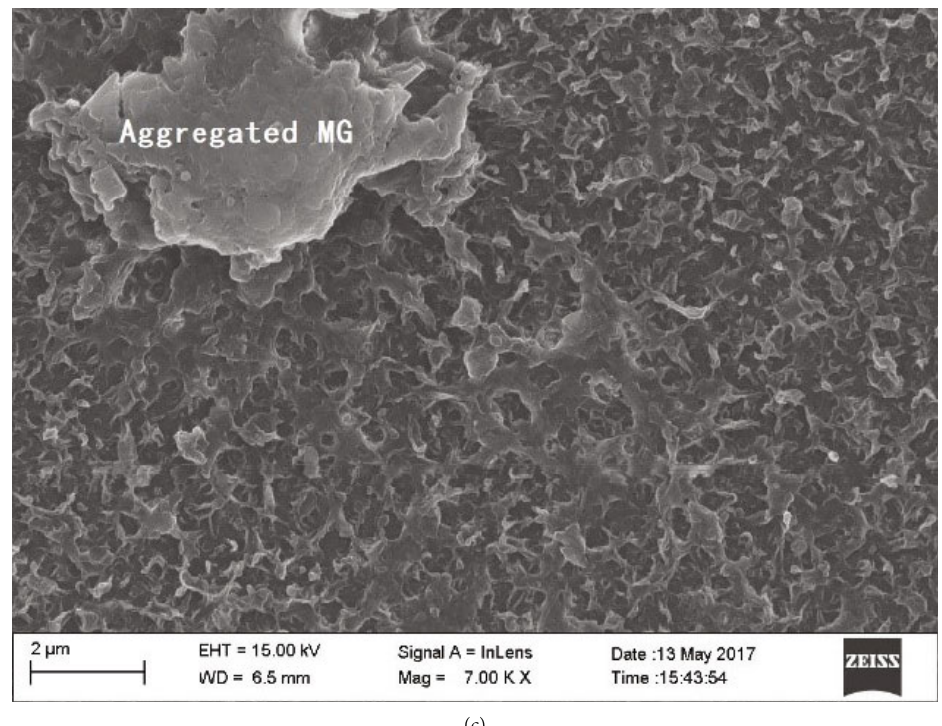
Figure 4: SEM images of the top surfaces of composite membranes prepared with di ff erent MG concentrations: (a) 0 wt%, (b) 0.004 wt%, and (c)